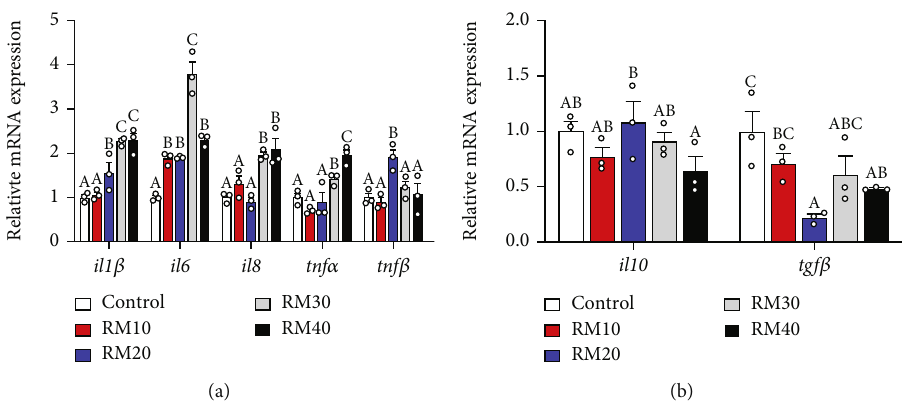
Figure 4: E ff ects of fi sh meal replacement by mixed plant protein on in fl ammatory response in the liver of yellow cat fi sh. (a) Relative mRNA expression of proin fl ammatory factor related genes. (b) Relative mRNA expression of anti-in fl ammatory factor related genes. Values are means ± S.E.M. ( n = 3 ). Letters (a – c) denote signi fi cance P < 0 : 05 (One-way ANOVA, Duncan post hoc